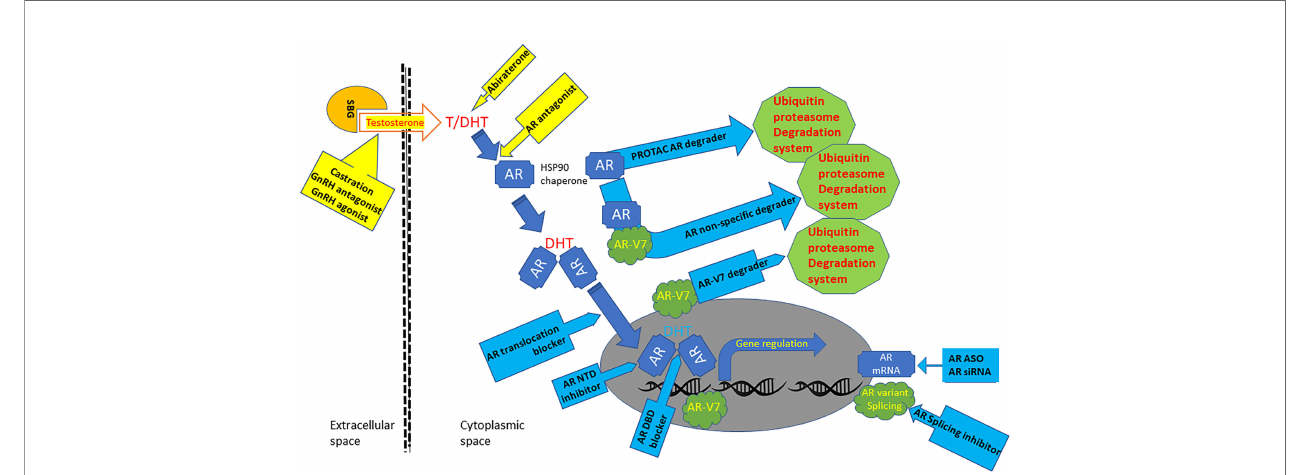
FIGURE 1 | Graphic scheme of AR-targeted agents. Androgens are bonded with steroid-binding globulins (SBG) in the bloodstream for systemic circulation. Androgen testosterone (T) is converted to potent form dihydrotestosterone (DHT) in the cytoplasm by 5a-reductase. The AR protein bonds with HSP90 chaperones and resides in the cytoplasmic compartment before androgen binding. Androgen binding alters AR conformation and promotes its translocation into the nuclear compartment, where it interacts with chromatin DNA to regulate gene expression. AR gene mRNA is aberrantly spliced in advanced prostate cancers to generate variant proteins like AR-V7, which is constantly active without androgen binding. Current clinical therapies for metastatic prostate cancers (yellow background box) include castration, GnRH agonist and antagonist, Abiraterone, and AR antagonists. Several AR-targeted treatments under development (blue background box) include AR PROTAC and non-speci fi c degraders, AR-V7 degraders, AR-NTD inhibitor, AR-DBD blocker, AR nuclear translocation blockers, AR splicing